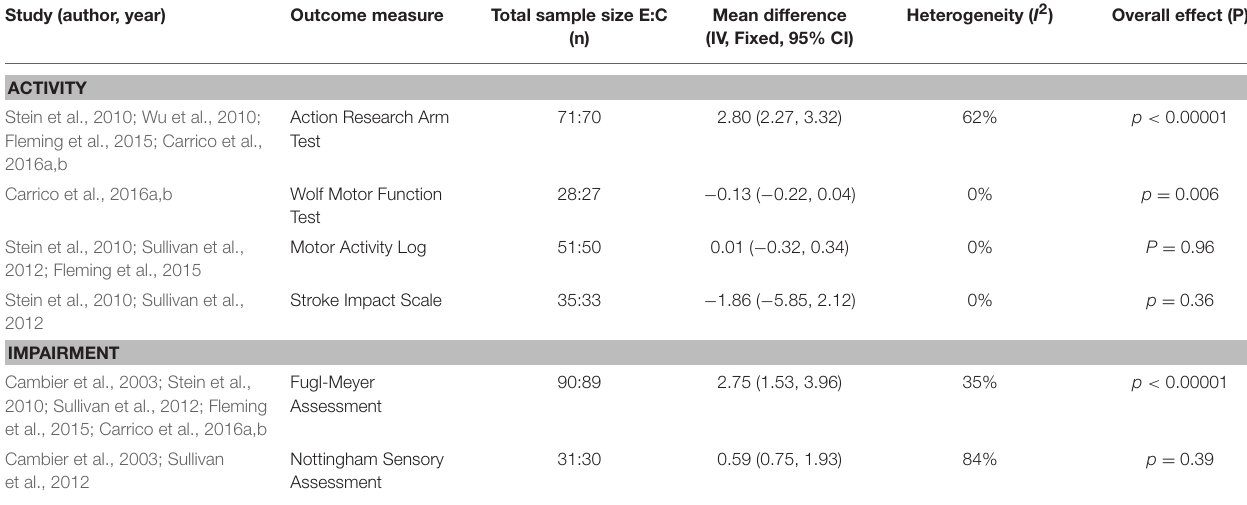
TABLE 3 | Effect size (95% CIs) for sensory training compared to sham stimulation. Study (author,